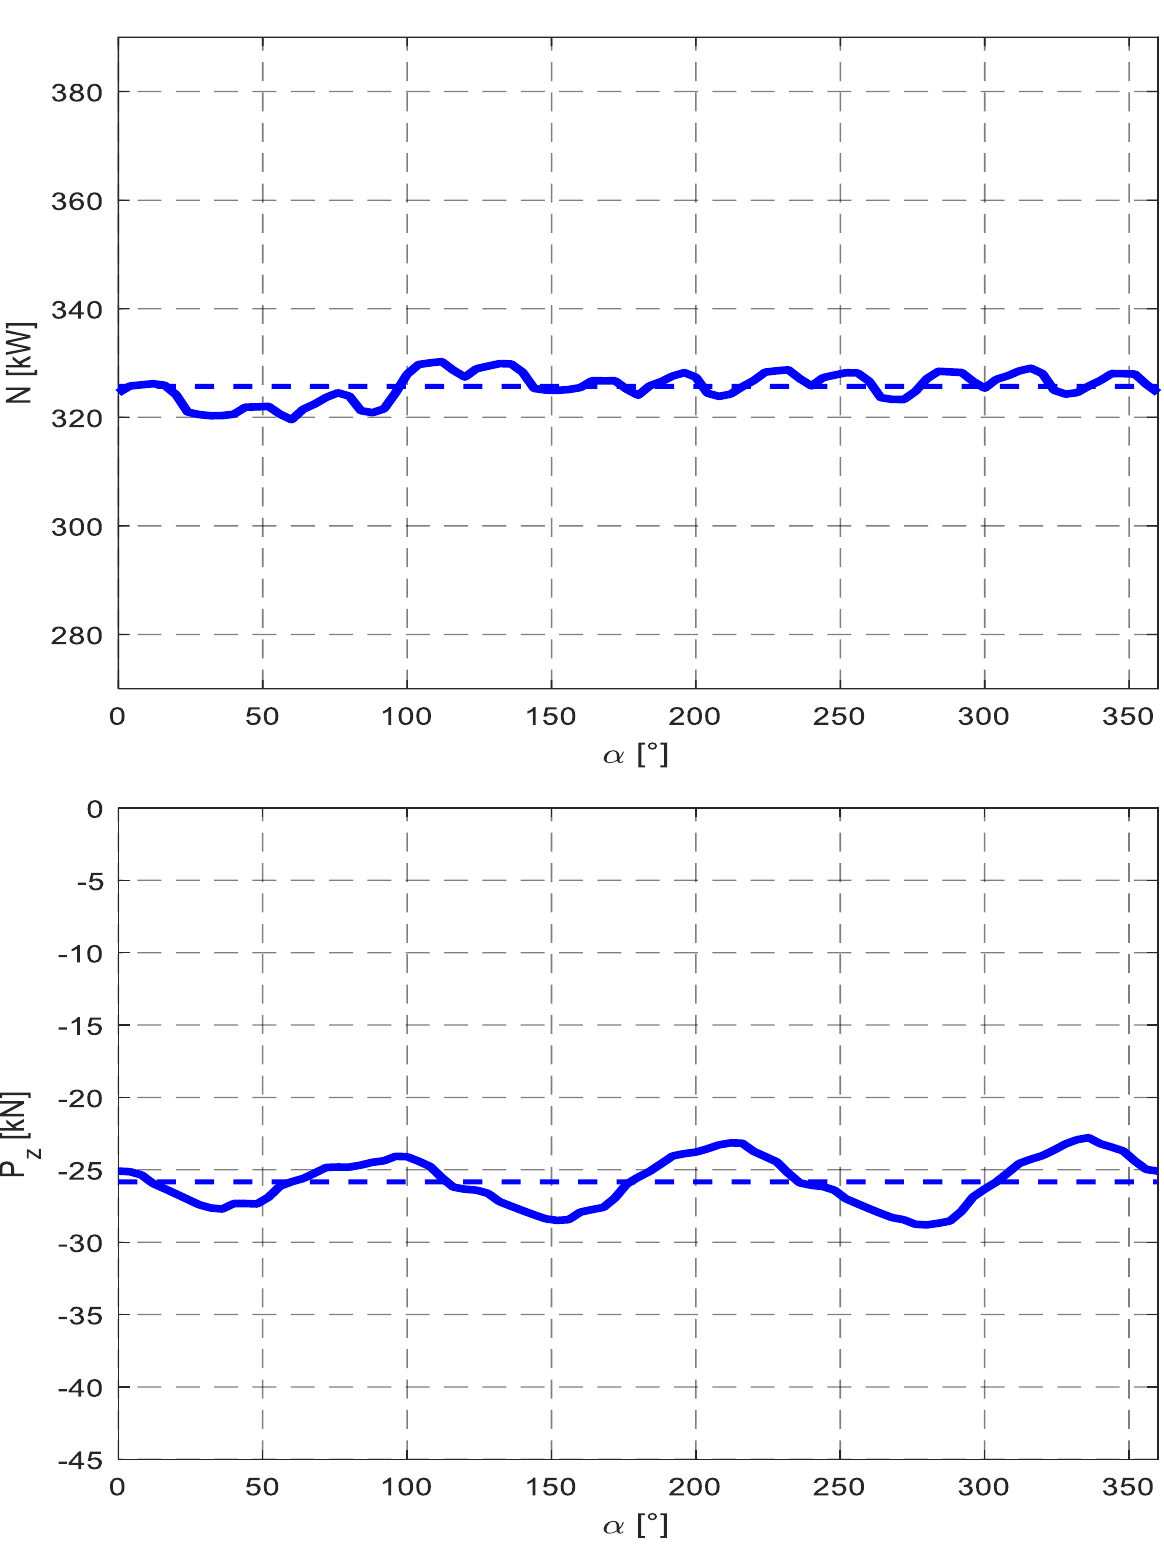
Figure 15. Waveform of the values of power N and cutting head impact force in the direction of shearer’s advance P z for pick arrangement 1c.